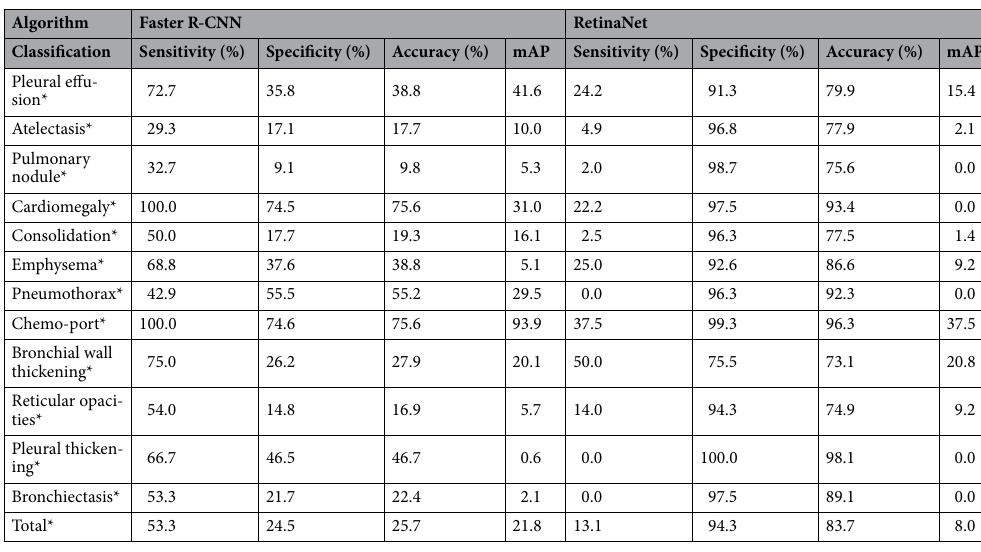
Table 2. Performance summary of Faster R-CNN and RetinaNet. Performance results were summarized on this table. Faster R-CNN showed higher sensitivity than RetinaNet. Some classes such as cardiomegaly or chemo-port showed 100% sensitivity. Others, which were not easily seen in chest X-ray compared to those of computed tomography, such as pleural effusion, emphysema, pleural thickening, and bronchial wall thickening were described by the faster R-CNN model. Compared to those of faster R-CNN, RetinaNet model showed higher specificity and accuracy. However, this model showed poor results on sensitivity, which were not good outcome for abnormal object detection. * p < 0.01 (results of faster R-CNN were compared to those of